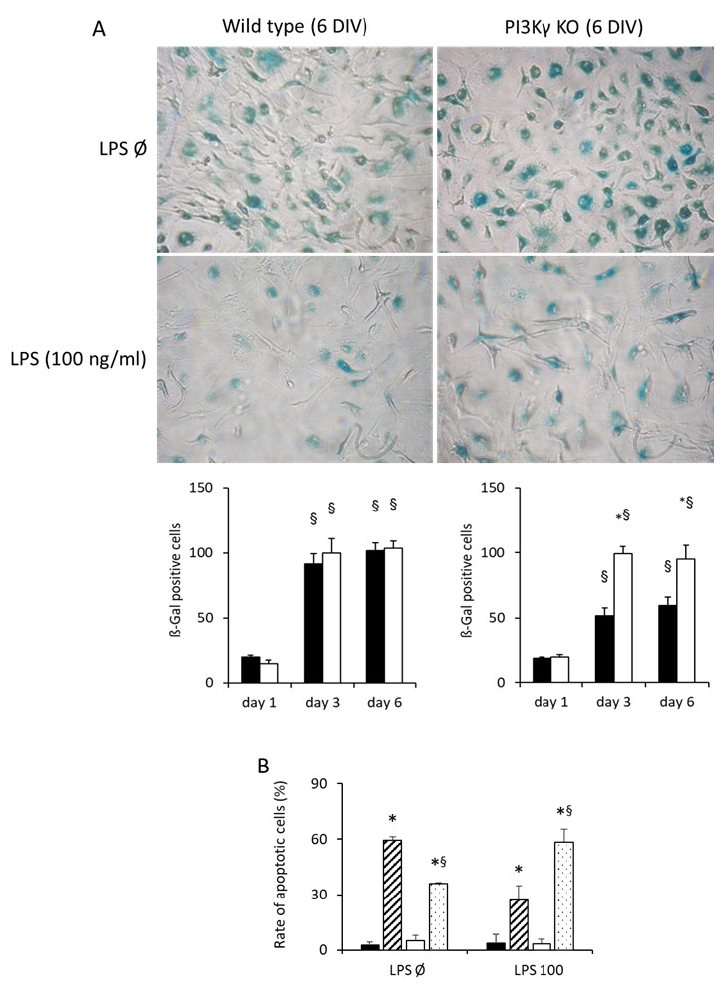
Figure 3. PI3K γ suppresses induction of senescence and apoptosis of LPS-activated microglia. ( A ) Primary microglia derived from wild-type (WT, black columns) or PI3K γ KO (white columns) mice were seeded (100,000/well) in a 12-well plate and incubated without or with LPS (100 ng/mL) for 1, 3 or 6 days, as indicated. Induction of apoptosis was monitored using senescence-associated β -galactosidase staining of cells (upper panel, representative pictures are shown for day 6). β-Gal-positive (blue) cells were counted, n = 3 per day and genotype, * § p < 0.05, * significant differences vs. WT microglial cells at the same time point, § significant differences vs. day 1 at the same genotype. ( B ) Rate of apoptotic (SubG1) cells after one or six days of in vitro incubation of microglial cells (wild-type microglia, day 1: black bars; wild-type microglia, day 6: hatched bars; KO microglia, day 1: white columns; KO microglia, day 6: dotted columns) without LPS stimulation (LPS Ø) and with LPS stimulation (LPS 100 (ng/mL)). Cells were harvested, fixed and permeabilized and subsequently analyzed for their DNA content using flow cytometry, n = 3 per day and genotype, * § p < 0.05, * significant differences between day 1 and day 6 within the same genotype, § significant dif- ferences between cells incubated without or with LPS (100 ng/mL) within the same genotype and time point. DIV: days in vitro.